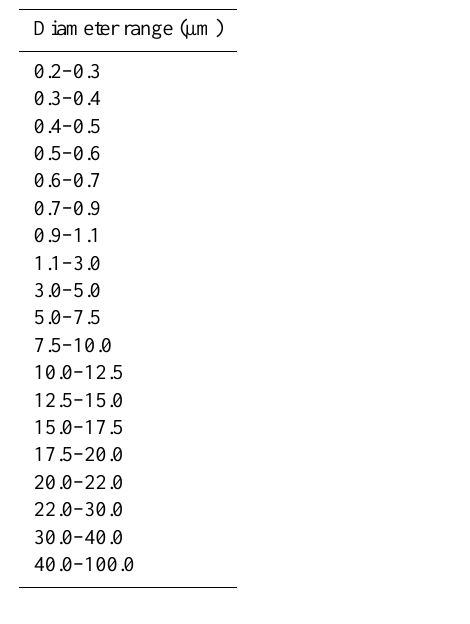
Table 1. The 19 size classes of LOAC for concentration measure-